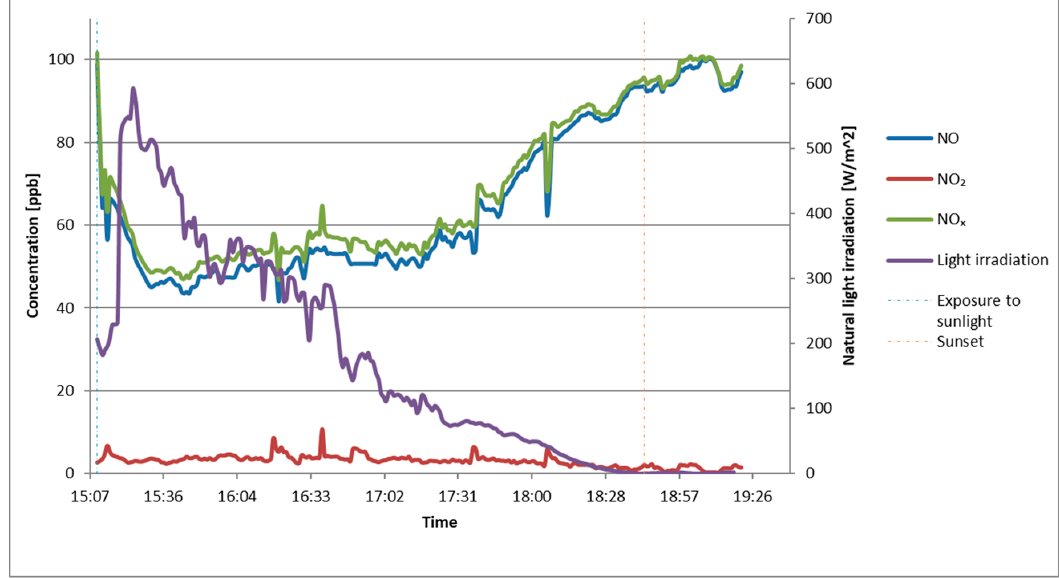
Figure 11. NO, NO 2 , and NO x abatement with natural UV irradiance measured with the novel test method.